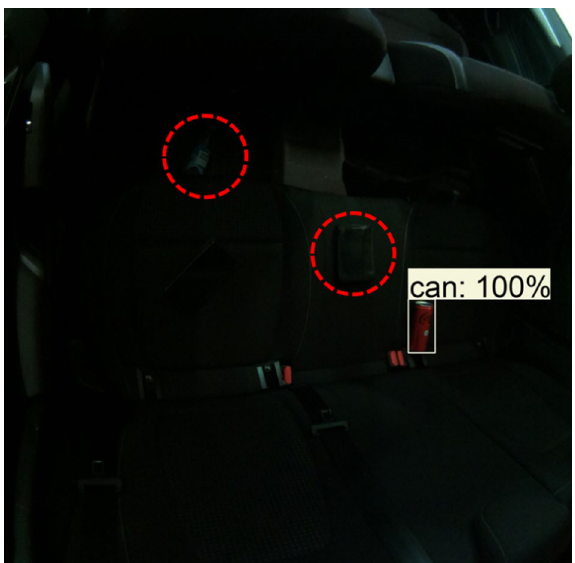
Fig. 23 Predicted test image lacking visibility. Red dotted circles correspond to the undetected items